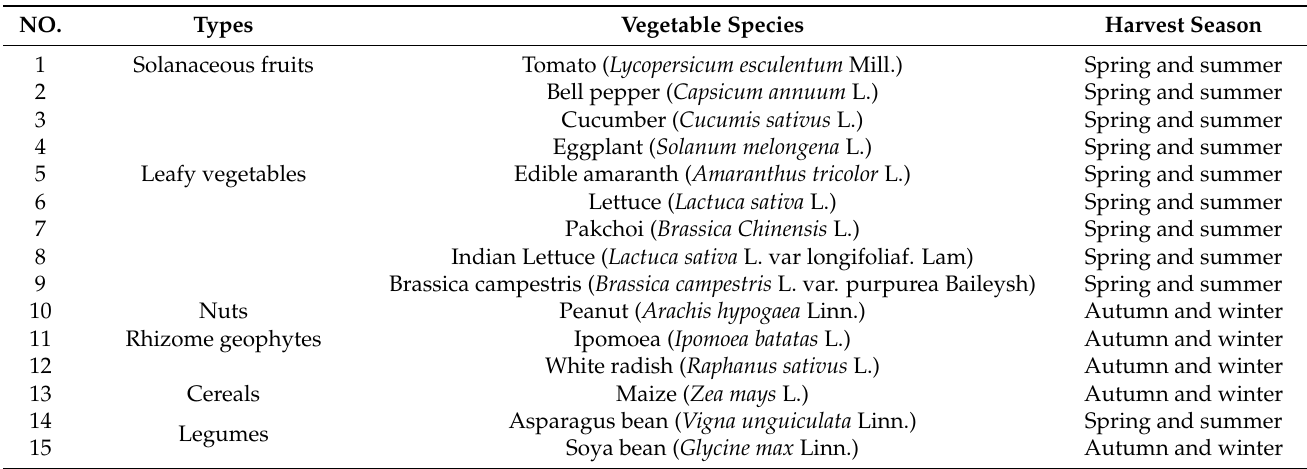
Table 1. Vegetable species used in the